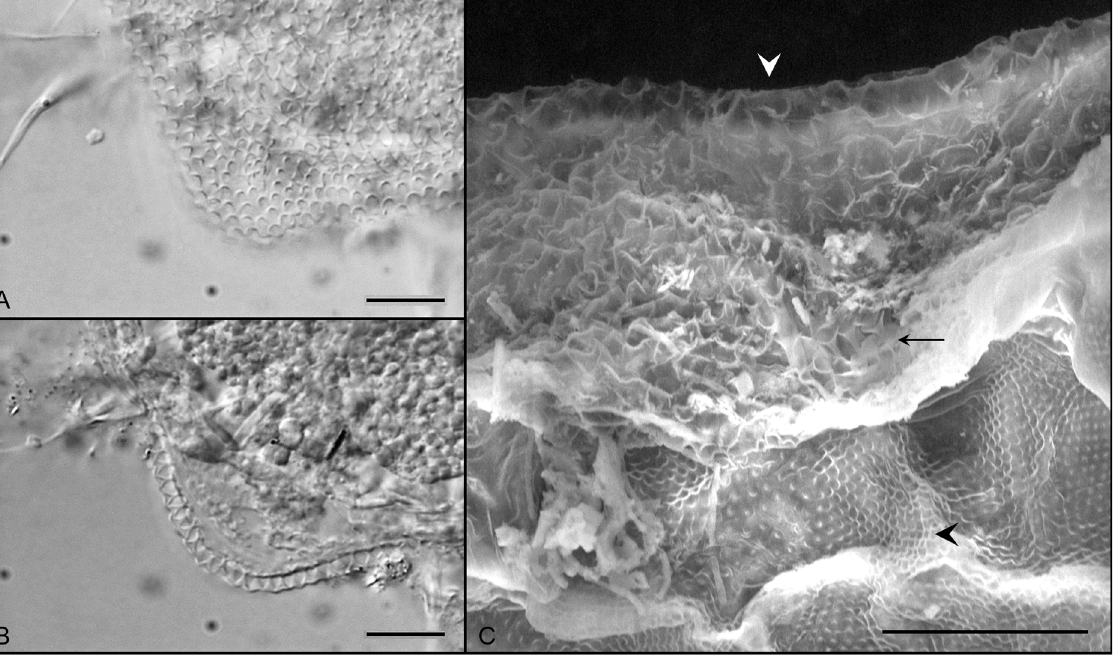
Fig. 7. Batillipes lusitanus sp. nov. A . Posterior portion of the body, showing the dorsal sculpture. B . Caudal apparatus, showing details of cuticular pillars. C . SEM photo showing the dorsal (white arrowhead) and ventral (black arrowhead) aspect of the cuticle. Pillars are also visible (black arrow). Scale bars = 10